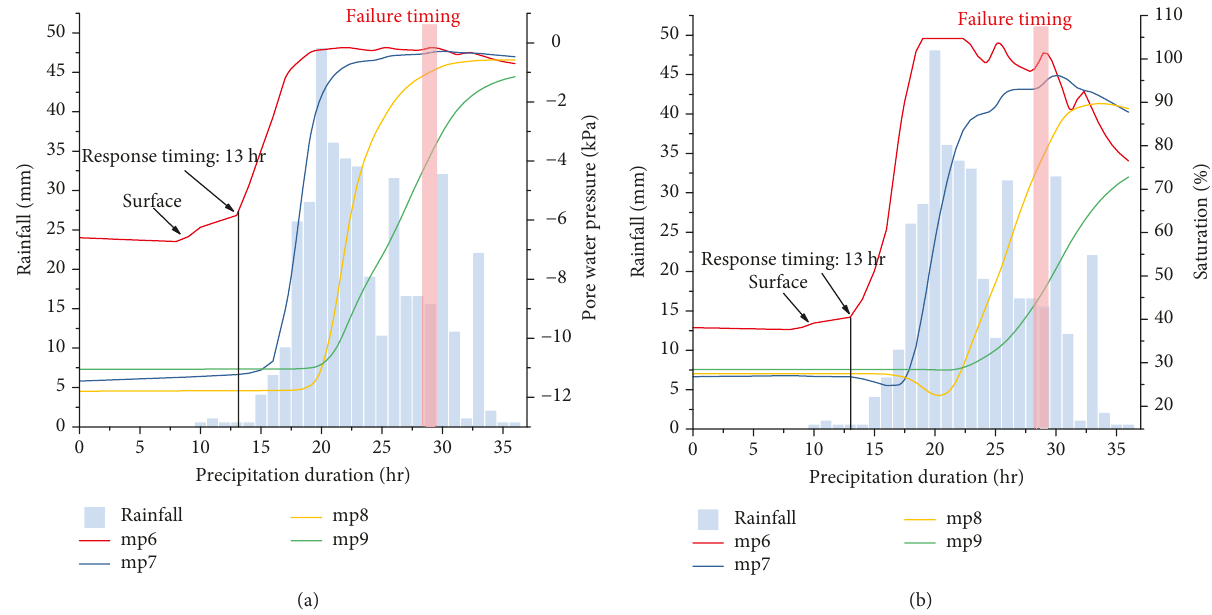
Figure 9: (a) The variation of the pore water pressure for monitoring points: mp6 – 9. (b) The variation of the saturation for monitoring points: mp6 –